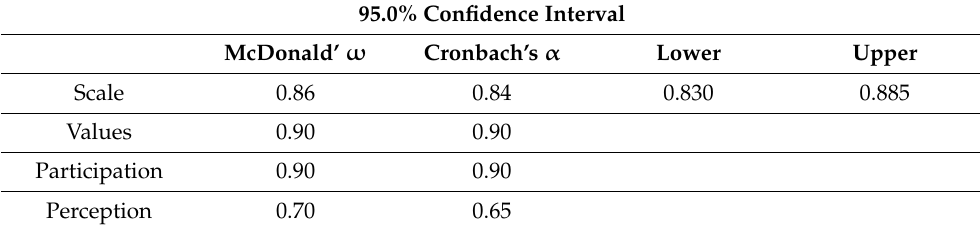
Table 2. Scale reliability